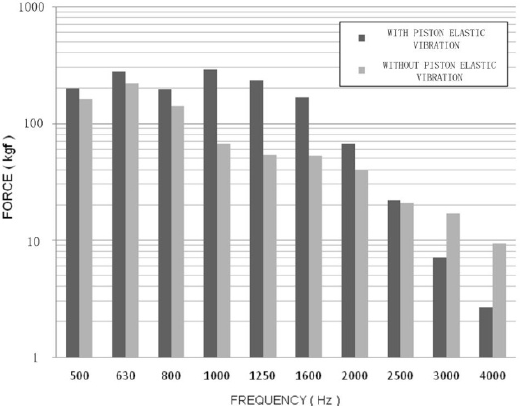
Figure 3. Collision forces of piston with/without dynamic features of the piston .